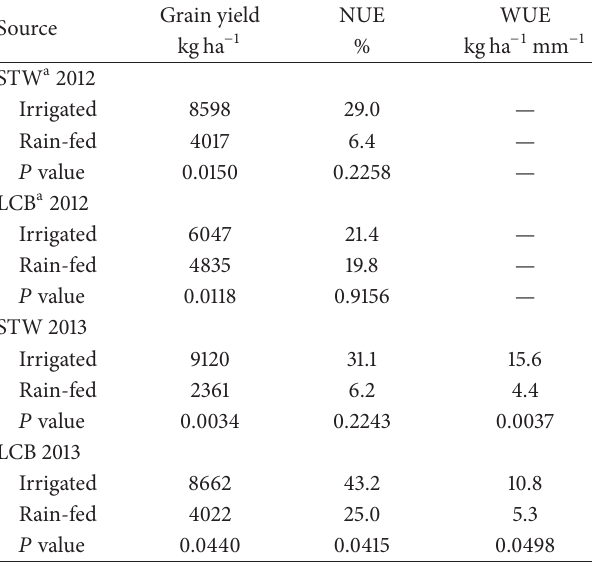
Table 5: Irrigated and rain-fed treatment means for grain yield, N use efficiency (NUE), and water use efficiency